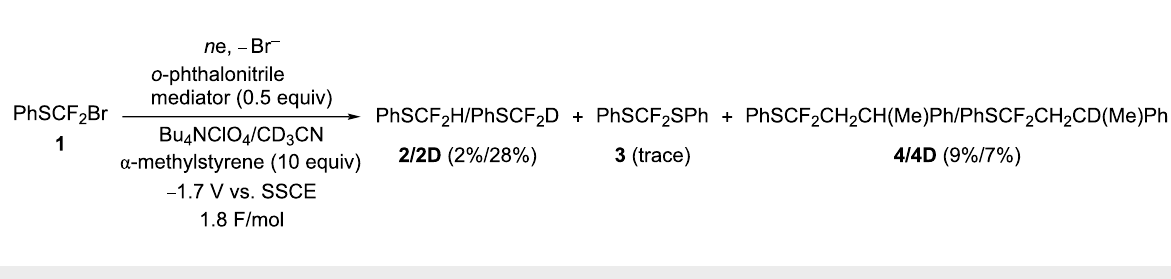
Scheme 9: Indirect cathodic reduction of compound 1 in CD 3